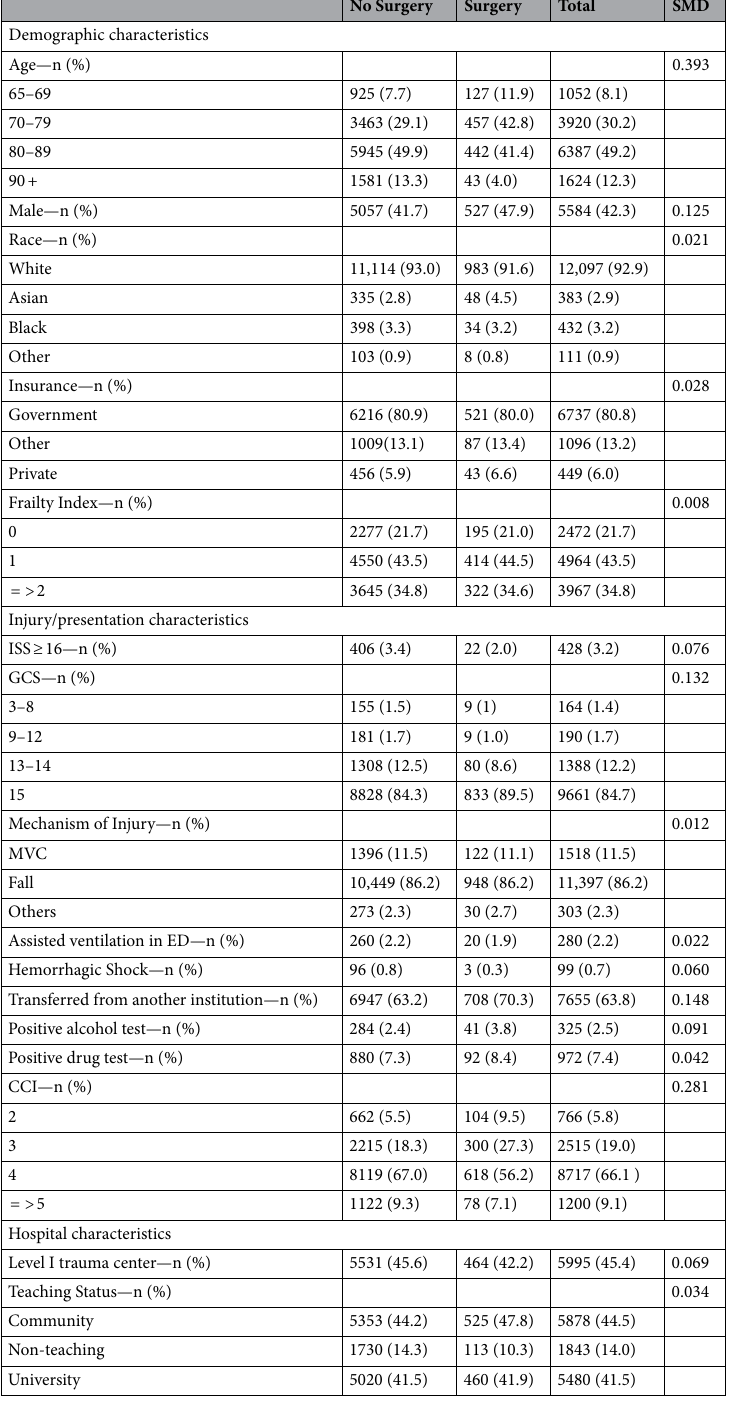
Table 1. Summary characteristics of the analytic cohort. SMD standardized mean difference, ISS Injury severity score, GCS Glasgow coma scale, MVC Motor vehicle collision, ED Emergency department, CCI Charlson comorbidity